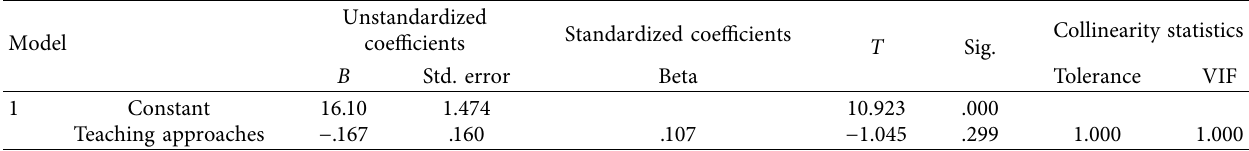
Table 10: Regression model to determine the degree of dependence of food security on the teaching approaches.